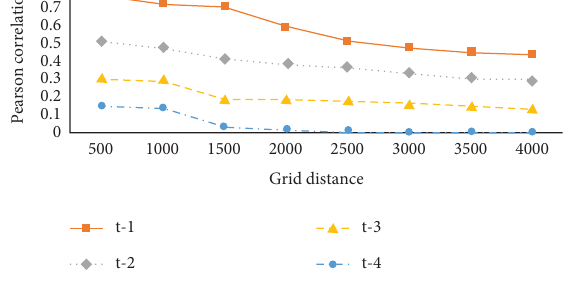
Figure 8: Pearson correlations.